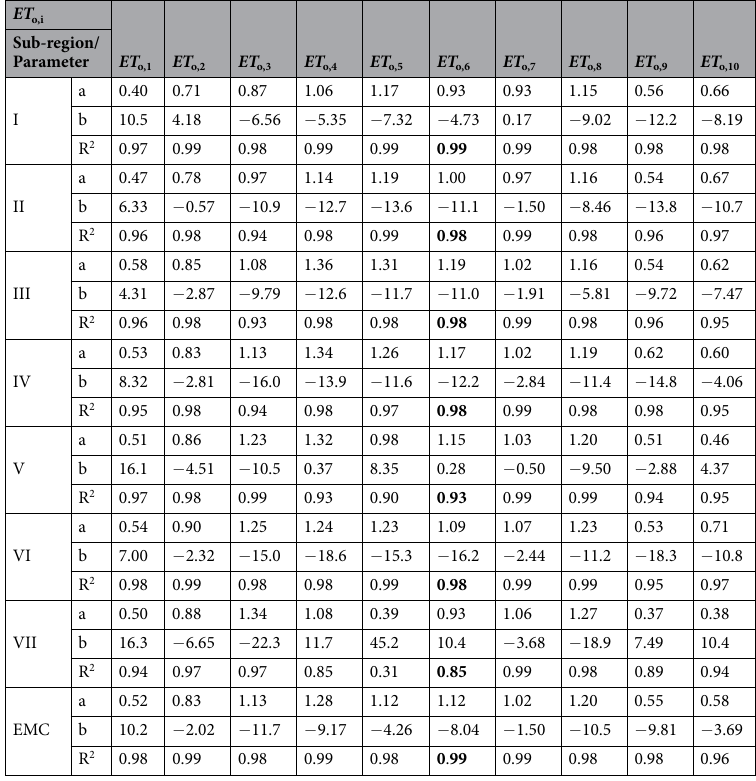
Table 6. The fitted a , b and R 2 values for correlating ET o,i with ET o,s in different sub-regions using Equation